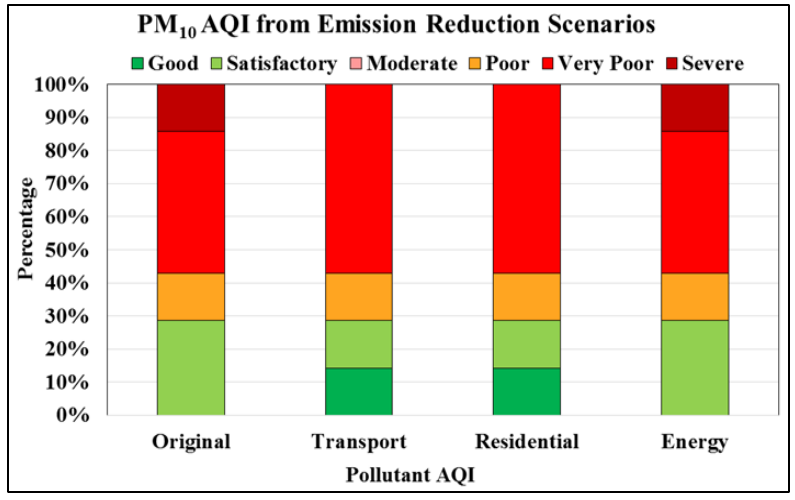
Figure 7. Wind rose plots displaying the wind direction and wind speed for simulated period over Delhi. ( a ) Observed, ( b ) simulated.